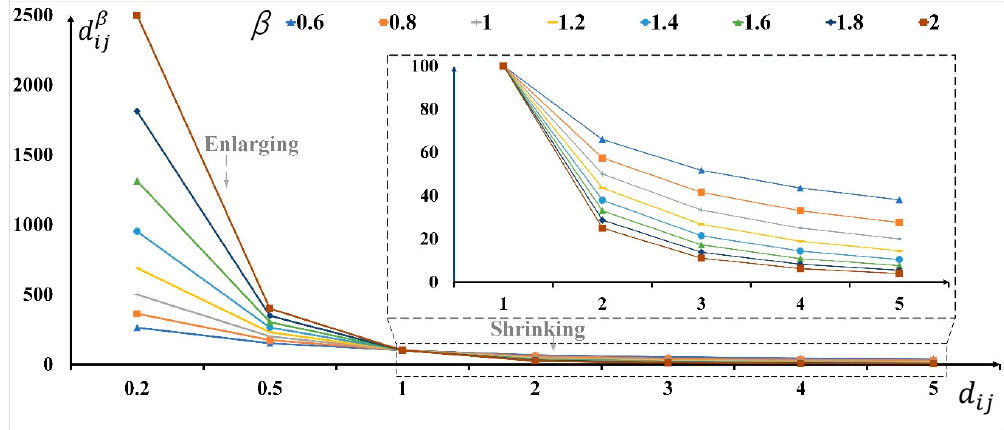
Figure 2. Schematic effect of different travel friction coefficients β in the line chart.